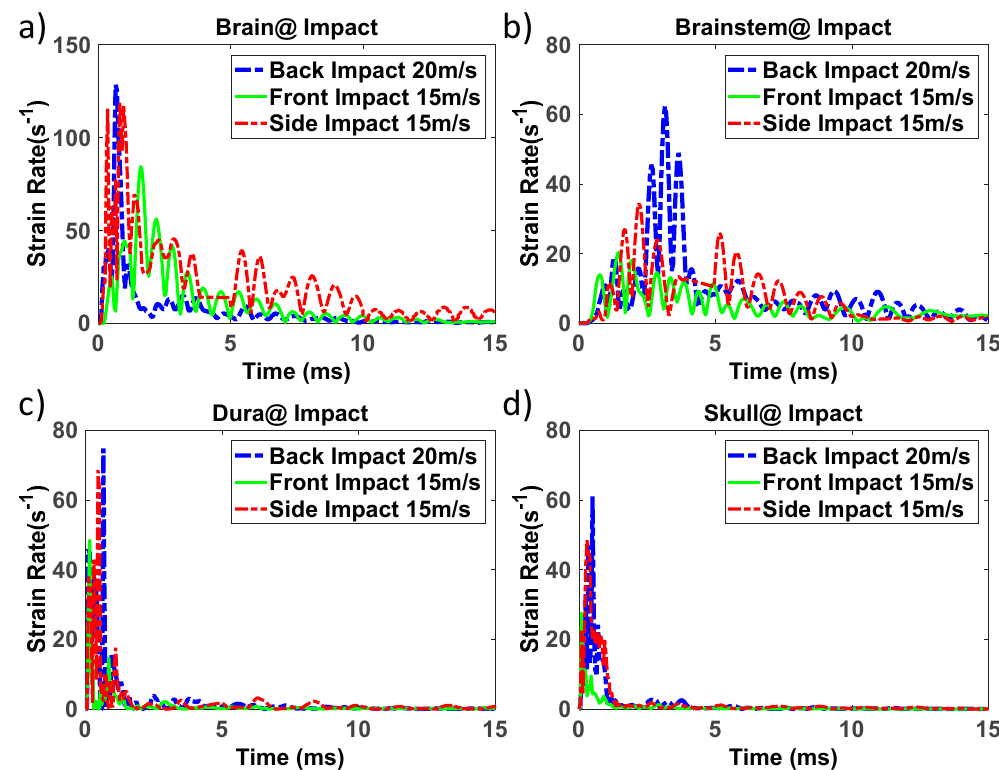
Figure 7. History of highest calculated strain rate under three blunt impact cases for: ( a ) brain, ( b ) brainstem, ( c ) dura, and ( d ) skull.